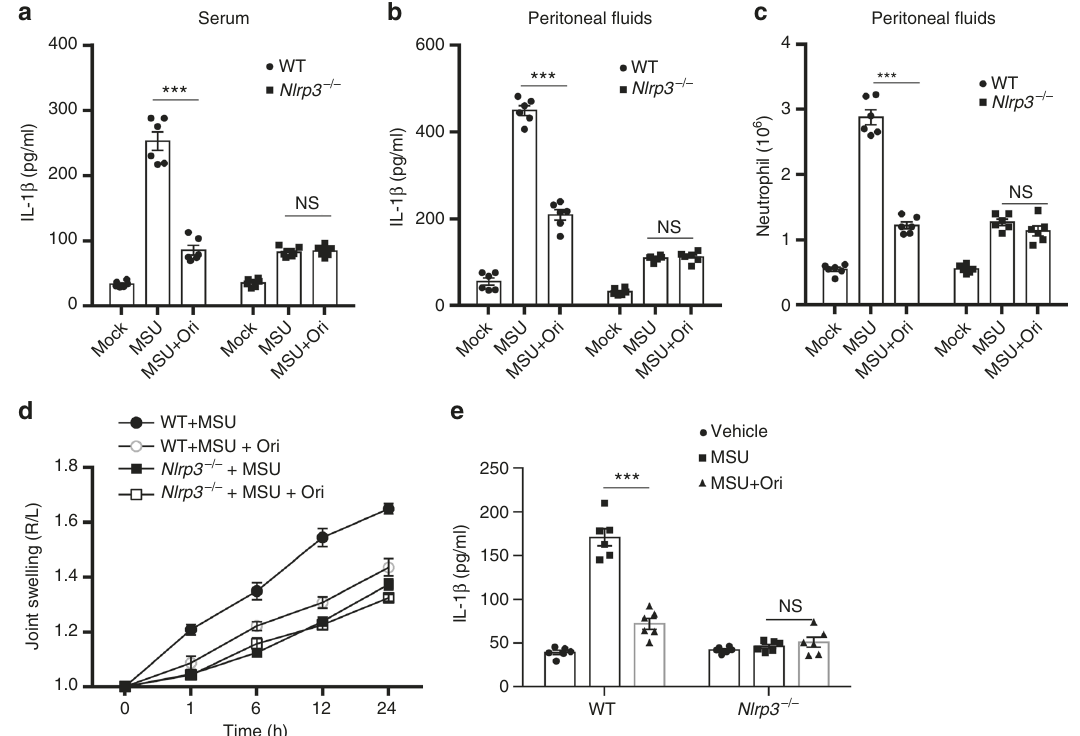
Fig. 6 Ori suppresses NLRP3-dependent peritonitis and gouty arthritis. a , b ELISA of IL-1 β in the serum ( a ) or peritoneal cavity ( b ) from WT or Nlrp3 -/- mice intraperitoneally injected with MSU crystals (1 mg/mouse) in the presence or absence of Ori (20 mg/kg). Data expressed as mean and s.e.m ( n = 6) and are representative of two independent experiments. c FACS analysis of neutrophil numbers in the peritoneal cavity from WT or Nlrp3 -/- mice intraperitoneally injected with MSU crystals (1 mg/mouse) in the presence or absence of Ori (20 mg/kg). Data are expressed as mean and s.e.m ( n = 6) and are representative of two independent experiments. d , e The joint swelling in different time points ( d ) or ELISA of IL-1 β ( e ) in joint culture from WT or Nlrp3 -/- mice, which have been intraarticularly injected with MSU with or without Ori (20 mg/kg). Data are expressed as mean and s.e.m ( n = 6) and are representative of two independent experiments. Statistical differences were calculated by unpaired Student ’ s t -test: ** P < 0.01, *** P <